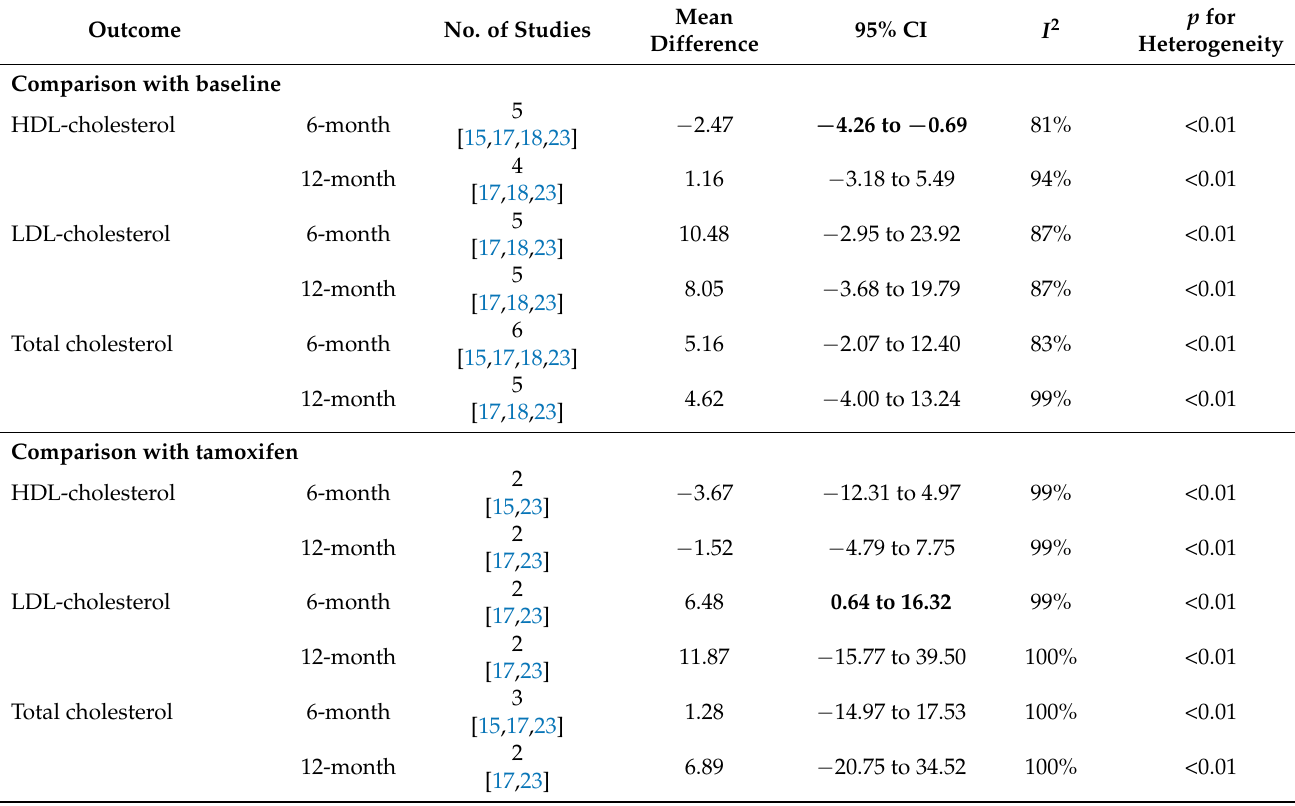
Table 4. Change in lipid profile during AI treatment.